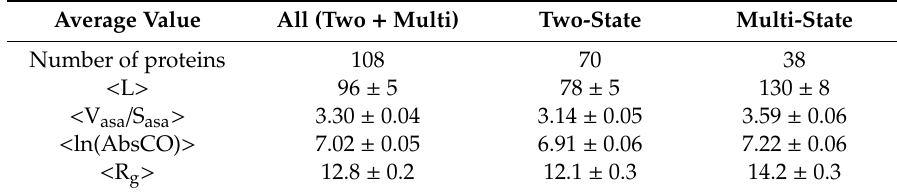
Table 2. Average values of structural parameters for 108 proteins. V asa / S asa = radius of cross-section. R g = radius of gyration. ln(AbsCO) = logarithm of the absolute contact order. L = length of the protein. Average Value All (Two + Multi)